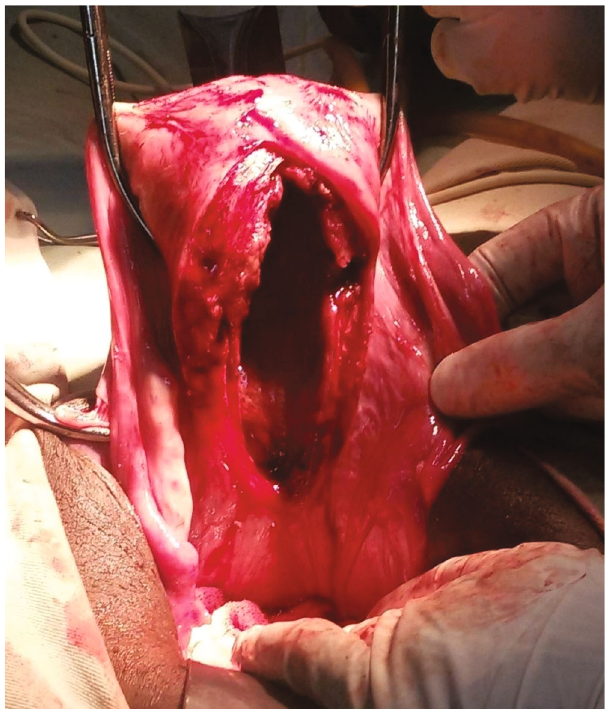
Figure 3: Abdominal view of the posterior uterine wall after repositioning using the Haultain